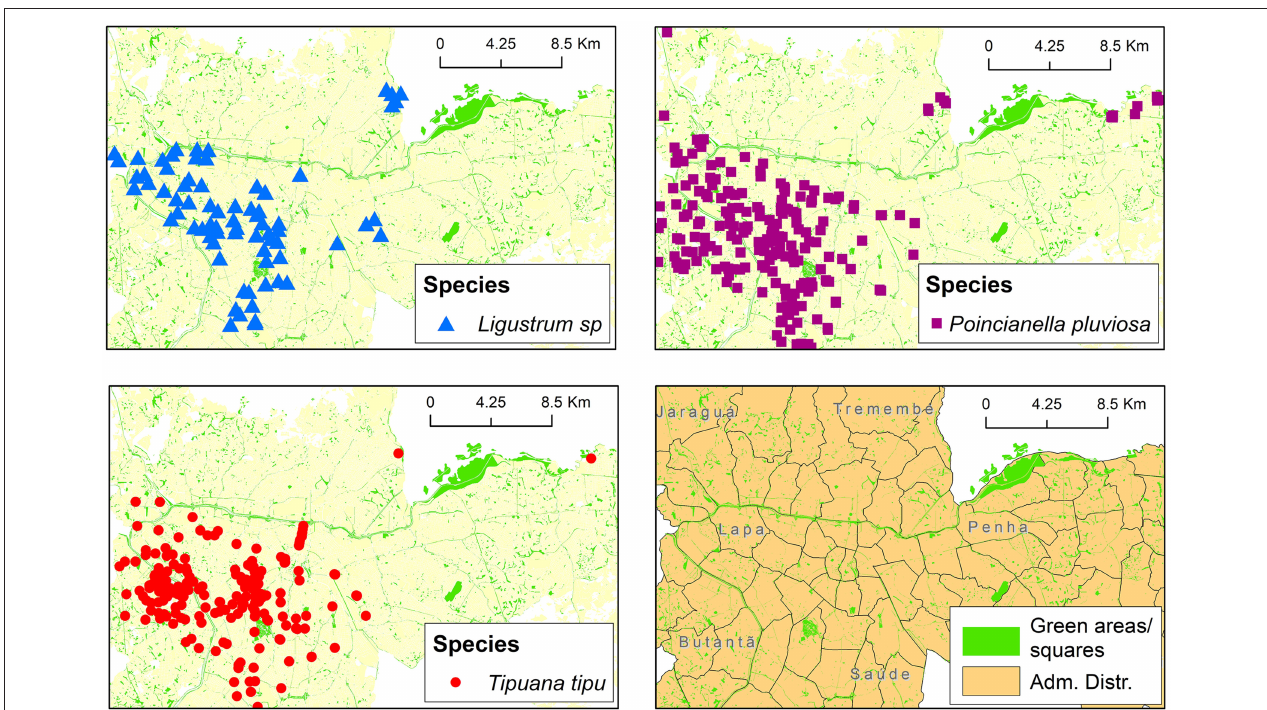
FIGURE 2 | Location of the sampled trees by species in São Paulo and the presence of green areas in the study